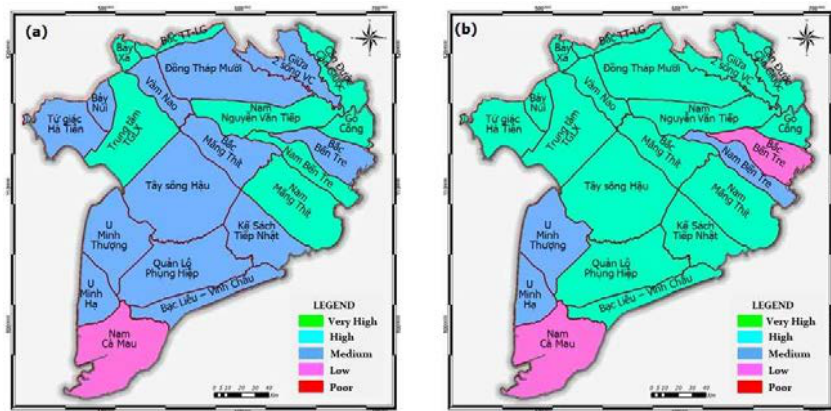
Fig. 3: Maps showing the overall water security index of (a) the economic activities dimension and (b) the water-related disaster dimension for each subregion in 2018